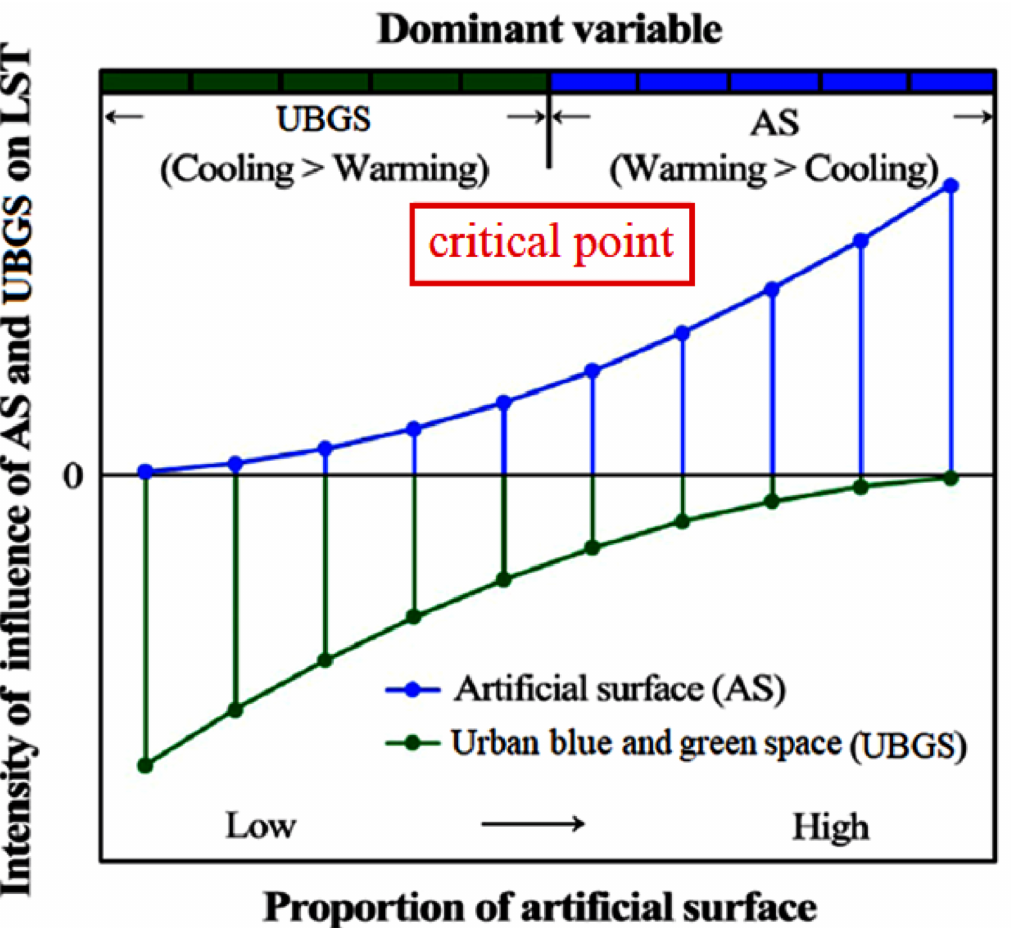
Figure 1. Concept graph showing the combined effect of UBGS (green) and AS (blue) on LST at various AS proportions. In the figure, when the proportion of AS is low, the cooling impact of UBGS is better established than the heating impact of AS, and UBGS is the dominant variable; when the proportion of AS exceeds the critical point, this is